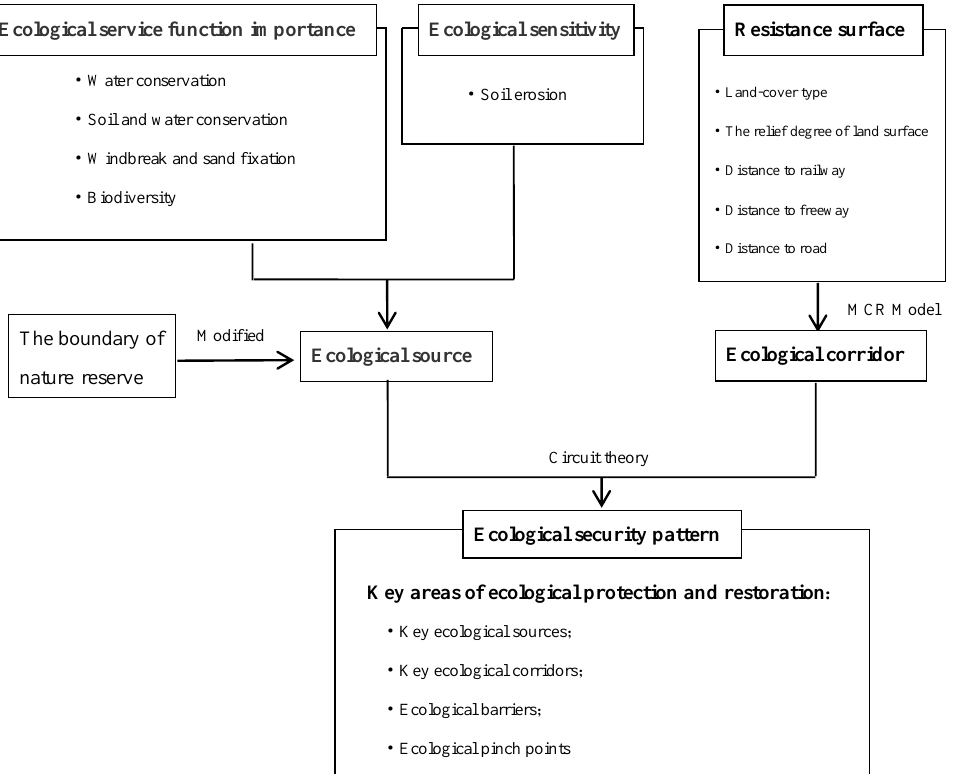
Figure 2. Methodological framework used in this study.